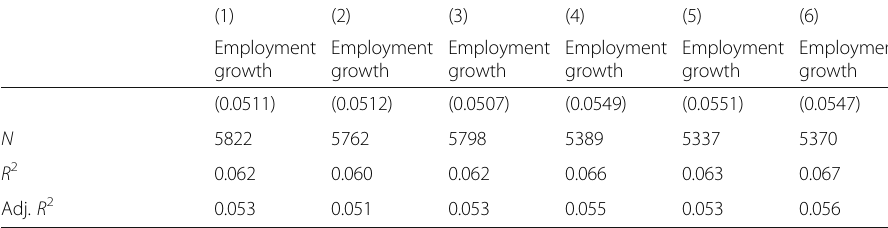
Table 4 Baseline model, employment growth and innovation